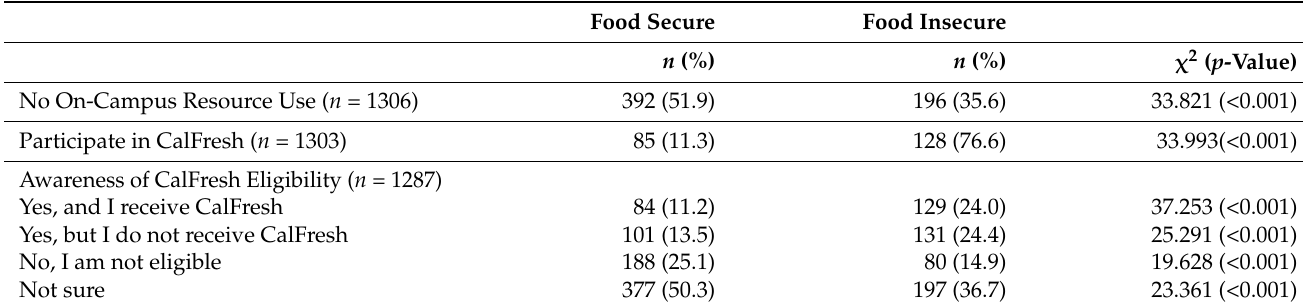
Table 2. Reported Food Access Resource Participation and CalFresh Knowledge and Participation.